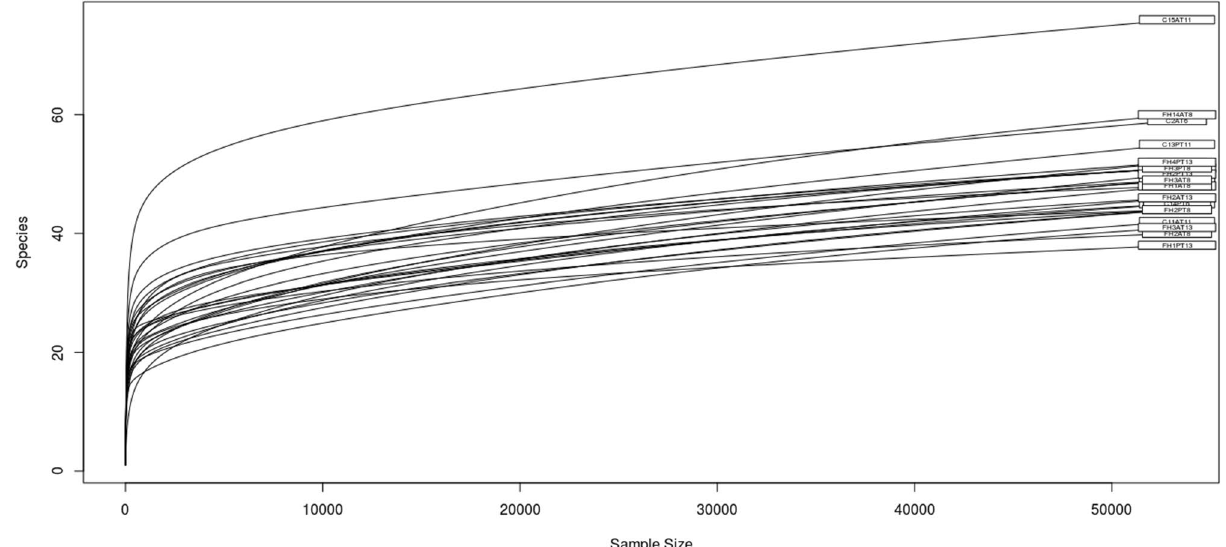
Figure 1. Rarefaction curves for each fish. Sequences were standardized to equal sample sizes for direct comparison.